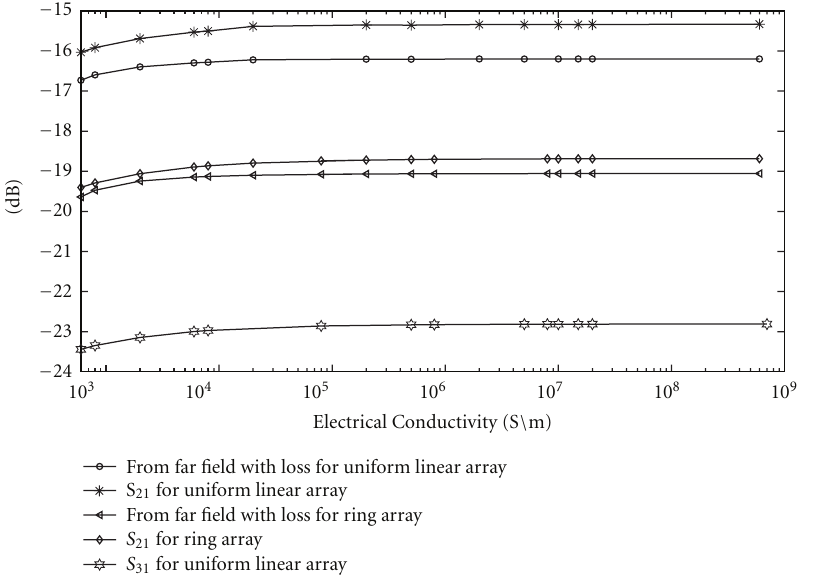
Figure 6: The computed spatial envelope correlations and scattering parameters between dipoles 1 and 2 versus their wire electric conductivity, in a MIMO system of three elements, arranged in a uniform linear array and in a ring array.